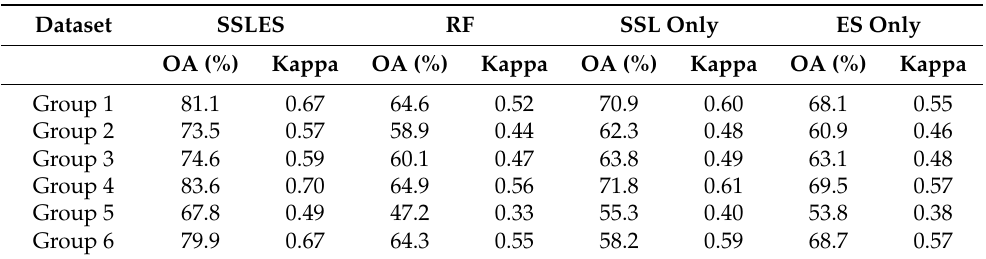
Table 6. Classification results for the six groups of band combinations of Sentinel-2 data, in terms of OA and kappa coefficient. Group 1: (All spectral bands), Group 2: (Red and infrared bands), Group 3: (All shortwave infrared bands), Group 4: (All red-edge bands), Group 5: (Red, infrared, and red-edge bands), Group 6: (Red-edge and shortwave infrared bands).